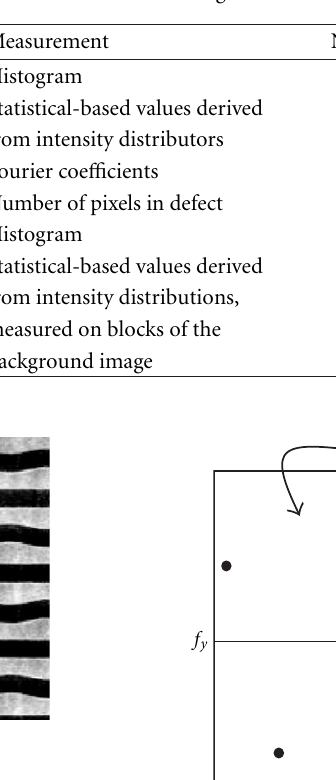
Table 1: Feature summary of defect and substrate regions in the imagery.